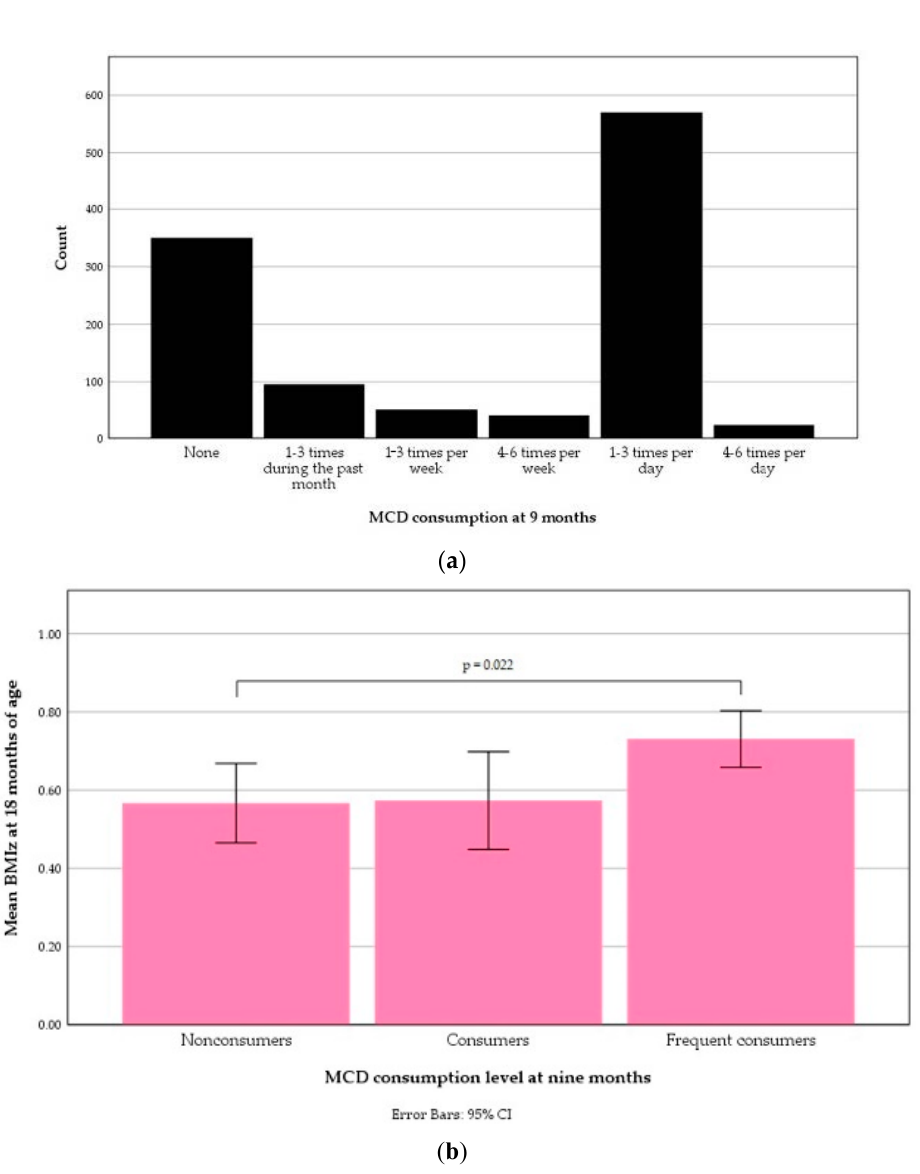
Figure 9. Milk cereal drink (MCD) consumption at nine months of age: ( a ) Distribution according to one-month-recall food frequency questionnaire responses; ( b ) An error bar of distribution in relation to body-mass index z -score (BMIz) at 18 months.